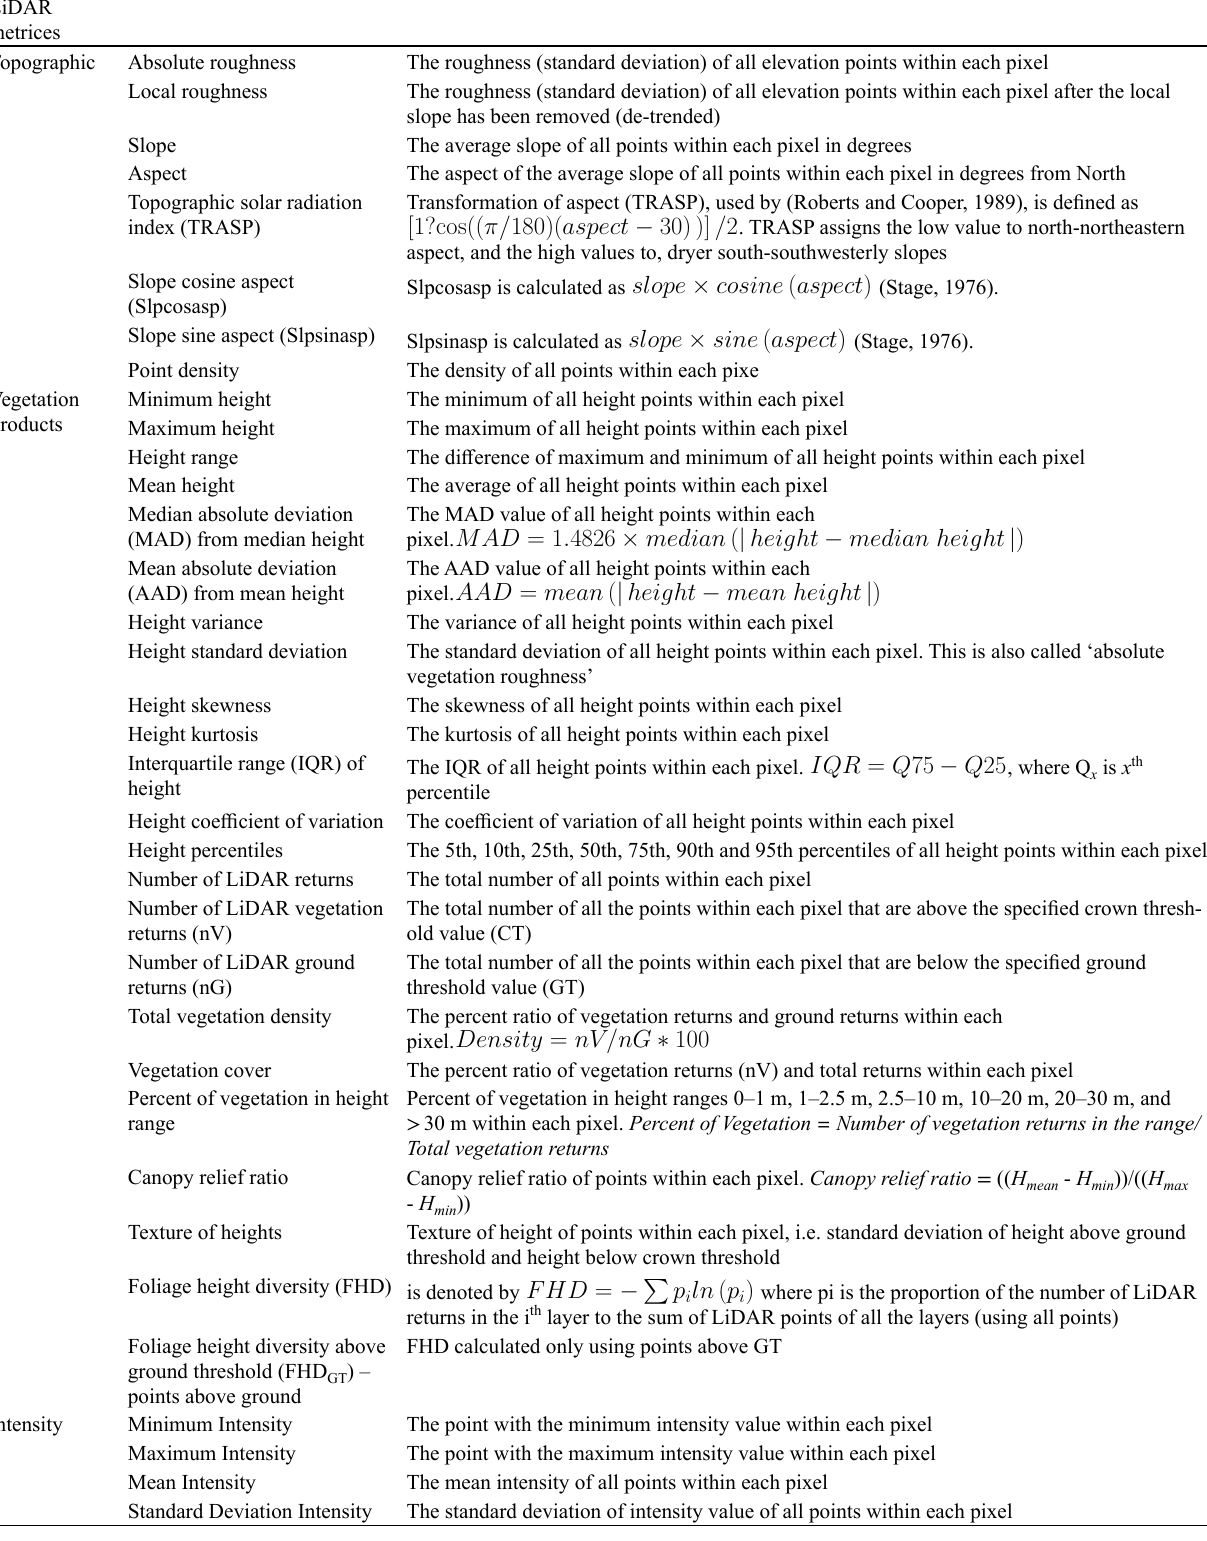
Table 1 Derived LiDAR metrices from the point cloud scan of the swamp environment Derived